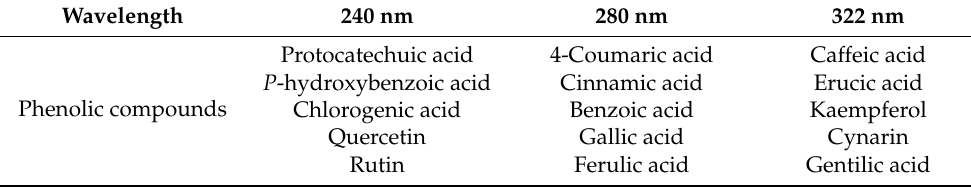
Table 1. Phenolic compounds were determined by HPLC at three